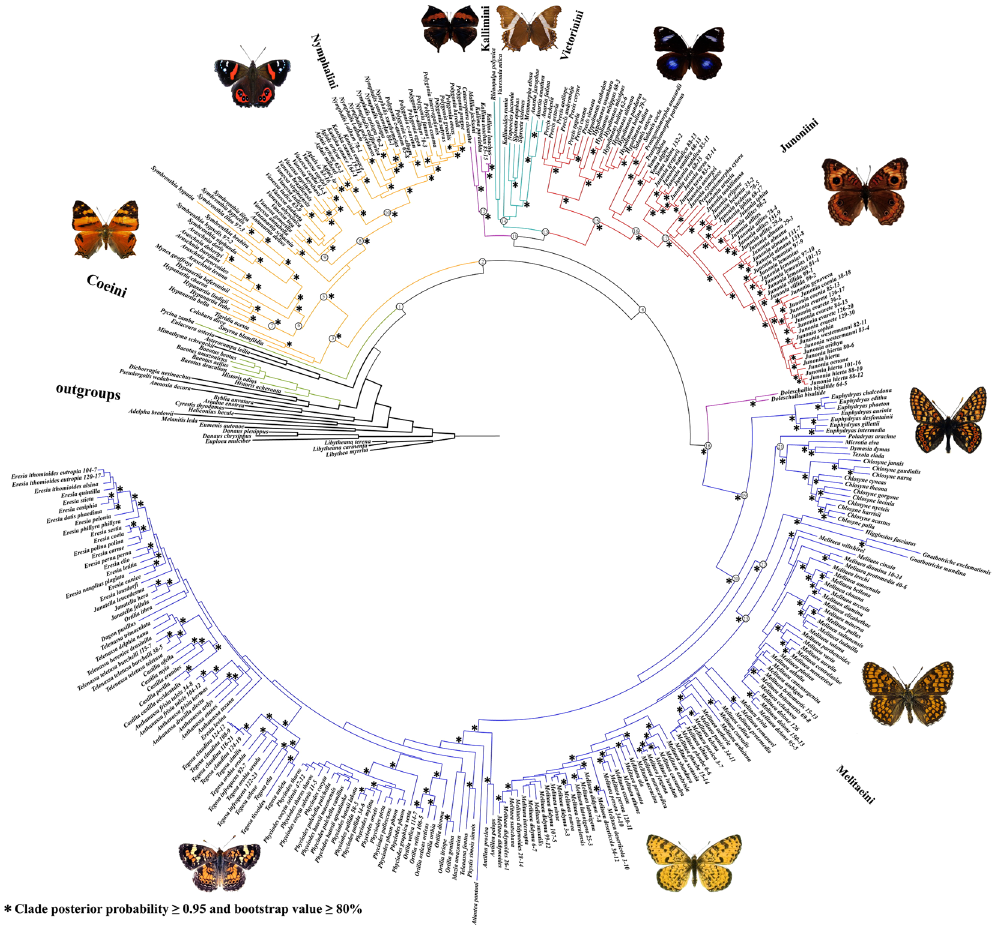
Figure 1. The specimen-level phylogenetic relationships of Nymphalinae based on maximum likelihood and Bayesian analyses (see under Methods). Images of Hypanartia lethe and Vanessa gonerilla from